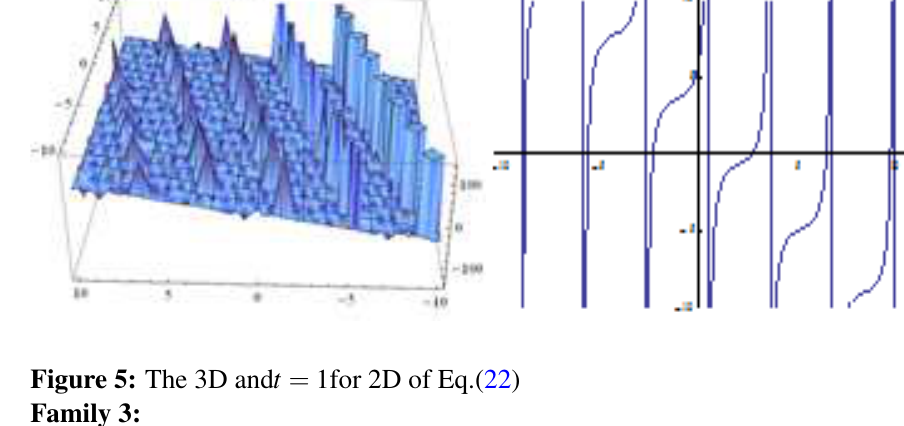
Figure 5: The 3D and t = 1for 2D of